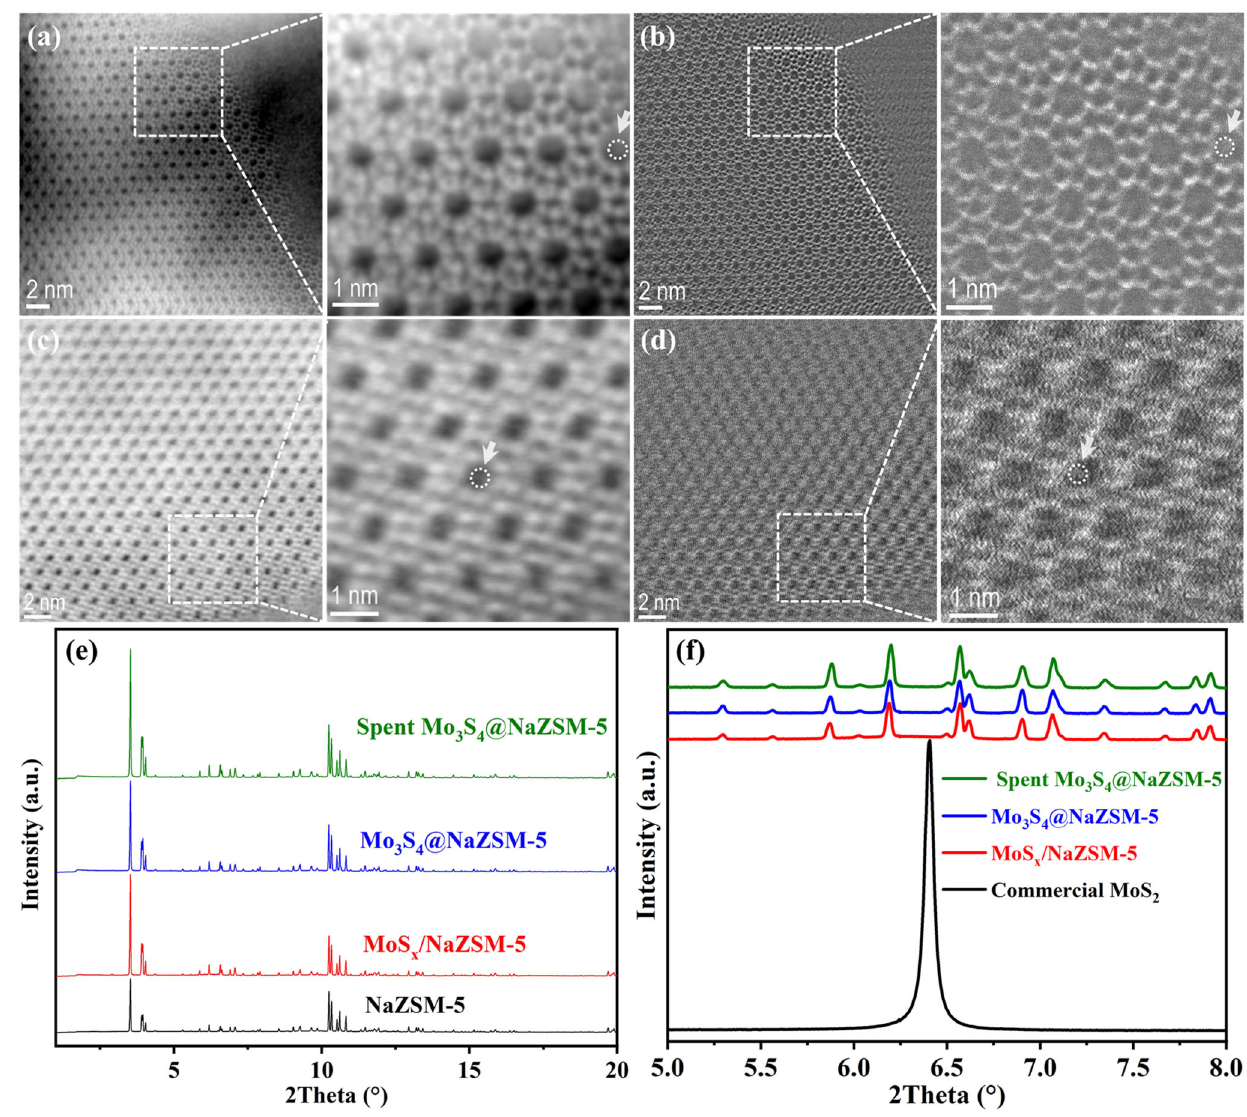
Fig. 2 | Structural characterizations of catalysts. a Scanning Transmission Elec- tron Microscope-Integrated Differential Phase Contrast (STEM-iDPC) image of fresh Mo 3 S 4 @NaZSM-5 and corresponding enlarged view from the dotted area; b Scanning Transmission Electron Microscope-High Angle Annular Dark Field (STEM-HAADF) images of the identical area shown in Fig. 2a and corresponding enlarged view from the dotted area, both STEM-iDPC image and STEM-HAADF image were captured in the same area simultaneously; c STEM-iDPC image of the used Mo 3 S 4 @NaZSM-5 sample and corresponding enlarged view from the dotted